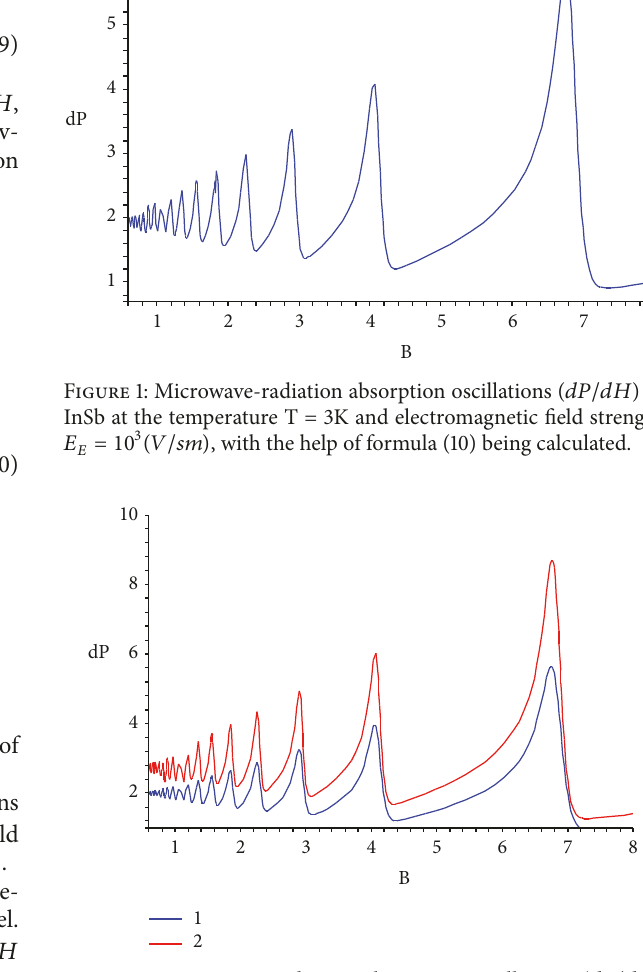
Figure 2: Microwave-radiation absorption oscillations ( 𝑑𝑃/𝑑𝐻 ) in InSb at different electromagnetic field strengths. 1 − 𝐸 𝐸1 = 10 3 (𝑉/𝑠𝑚) ; 2 − 𝐸 = √2 ⋅ 10 3 (𝑉/𝑠𝑚) 𝐸2